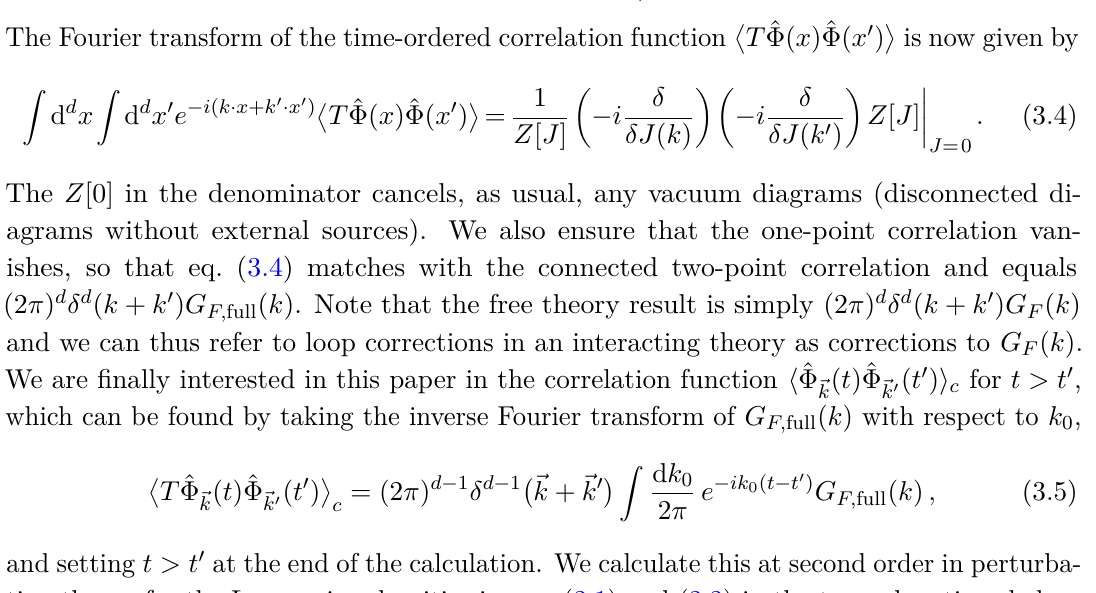
Figure 1 . (Left) One-loop contribution to the one-point function in a λφ 3 theory. (Right) The corresponding Y counterterm